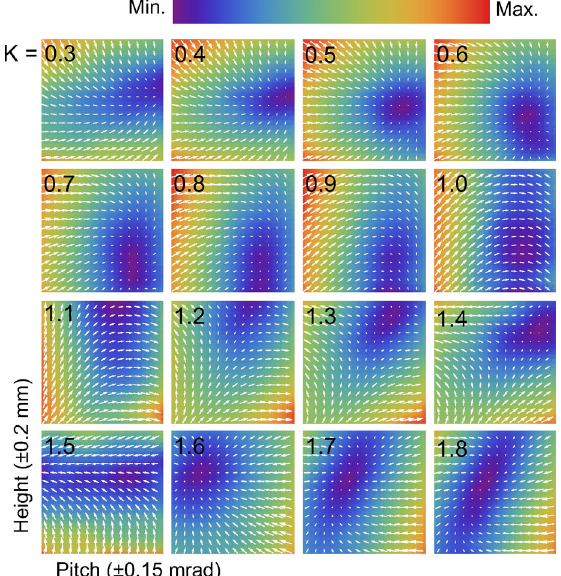
FIG. 68. Position and angle changes of the electron orbit in the vertical plane at the undulator exit ( Δ y and Δ y 0 ), represented as vertical and horizontal components of small white arrows, as a function of undulator pitch and height, individually plotted for undulator K values ranging from 0.3 to 1.8. The underlying colors correspond to the lengths of the arrows, i.e., the deviations from zero orbit change, and illustrate the dependence of the natural focusing strength and center on the K value. The plots for the different K values are individually normalized to illustrate the focusing and bending